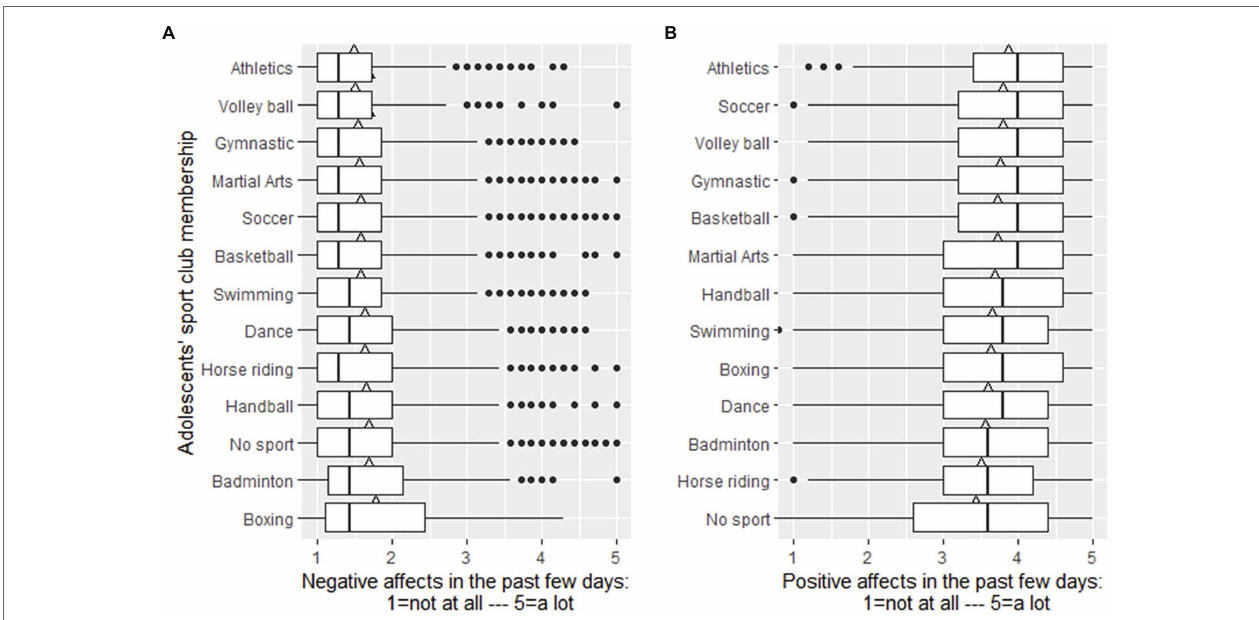
FIGURE 1 | Negative and positive affects along the most practice French sports club memberships and those who do not practice sports among adolescents aged between 10 and 18 years. The left panel (A) depicts negative affect-related results. The right panel (B) depicts the main effect of the sports club membership on positive affects. Only those sports are depicted that were mentioned by at least 240 adolescents. The line within the boxes indicates the median value, while the triangle on the top of the boxes indicates group means, and the dots indicate extreme values